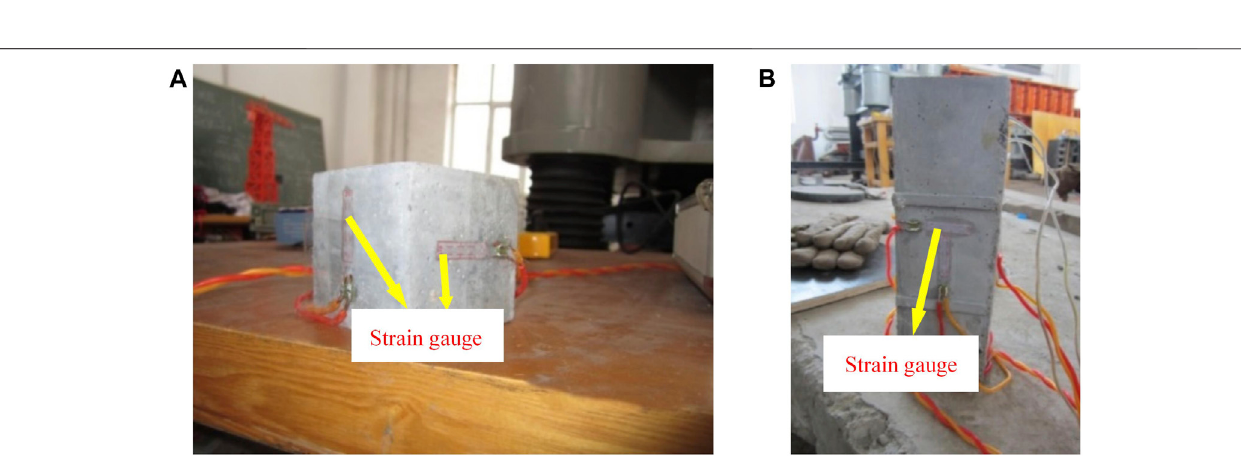
Frontiers in Materials |